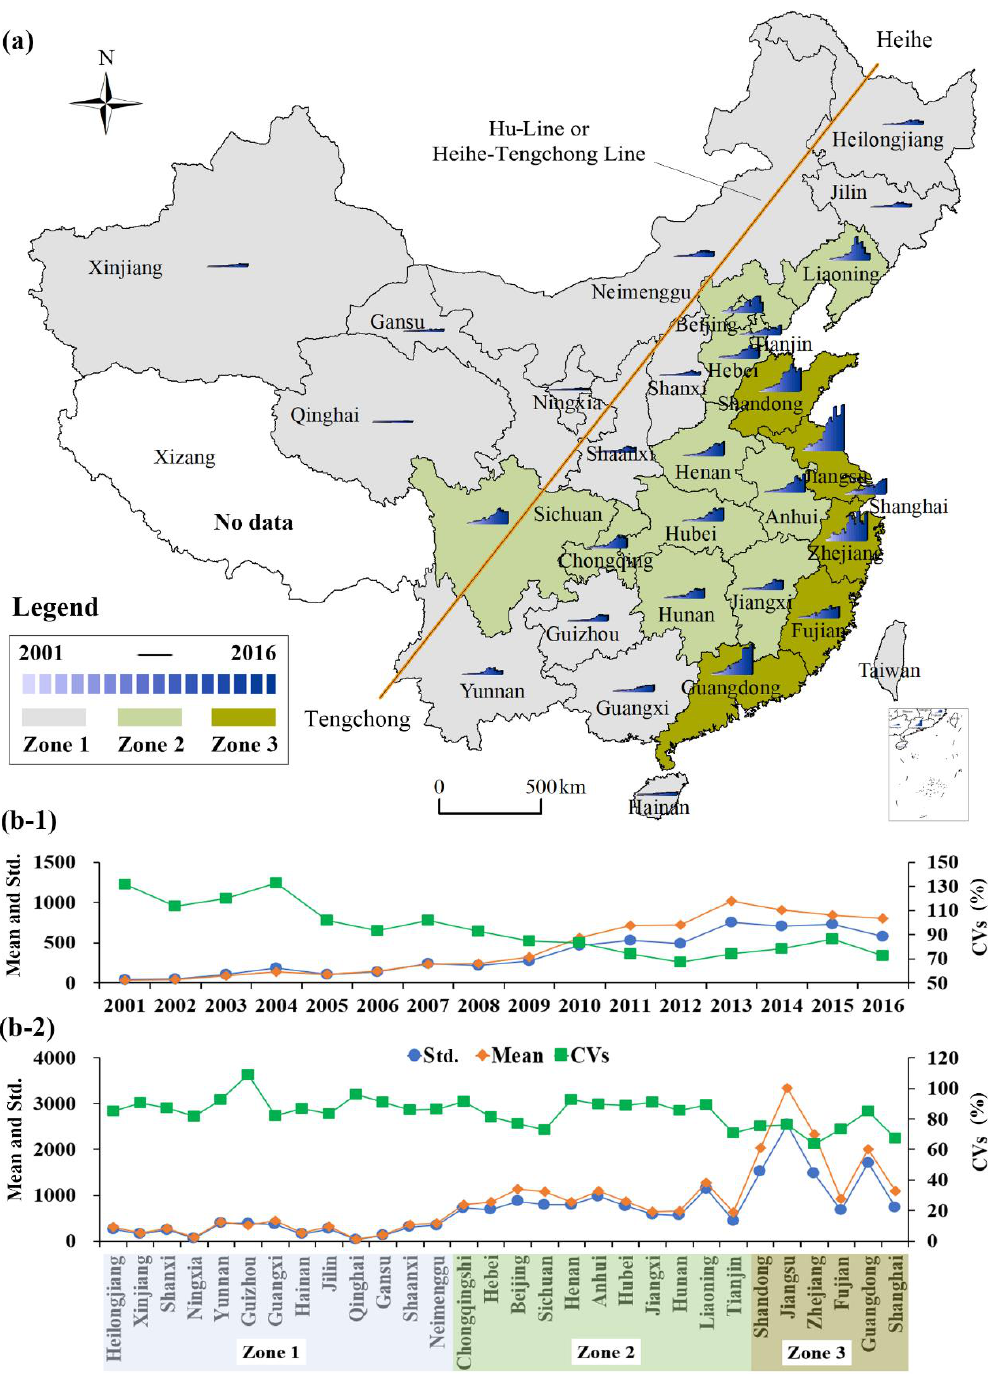
Figure 7. The spatial and temporal evolution of China’s land finance (Zone 1—Western areas, Zone 2—Central areas, and Zone 3—Eastern coastal areas).